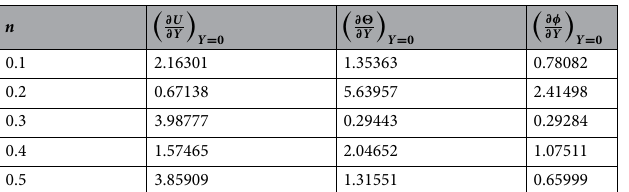
Table 3. Numerical results of skin friction